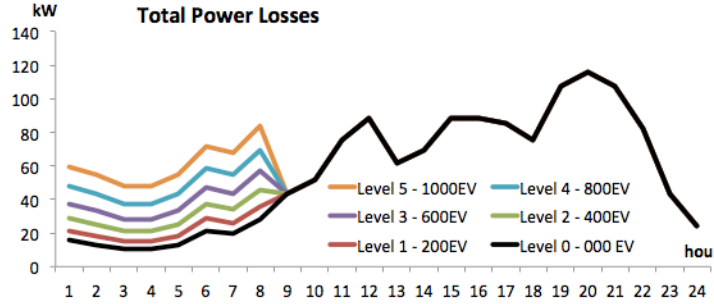
Figure 3. Off-peak load scenario: 24-h power losses by EV penetration